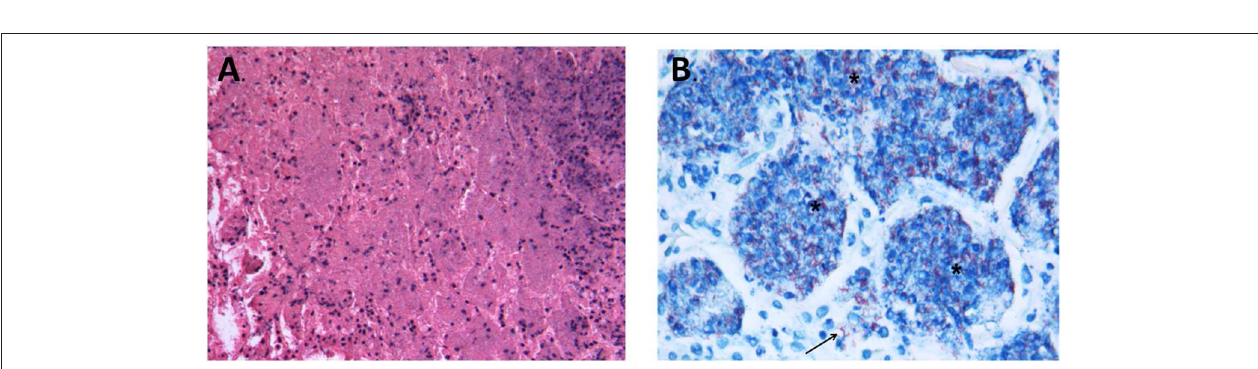
FIGURE 5 | (A) Representative image of pulmonary necrosis in animals infected by strain 46P on day 28 postinfection. The image shows the complete loss of pulmonary tissue architecture over large areas, with cellular debris, picnotic and fragmented nuclei and acidophilic material occupying the extracellular space (200X magnification). (B) Ziehl-Neelsen stain showing specific necrotic areas with the presence of large ammounts of acid-fast bacteria within the necrotic tissue (*) but also free in the interstitial space (arrow) (1000X magnification; stained with